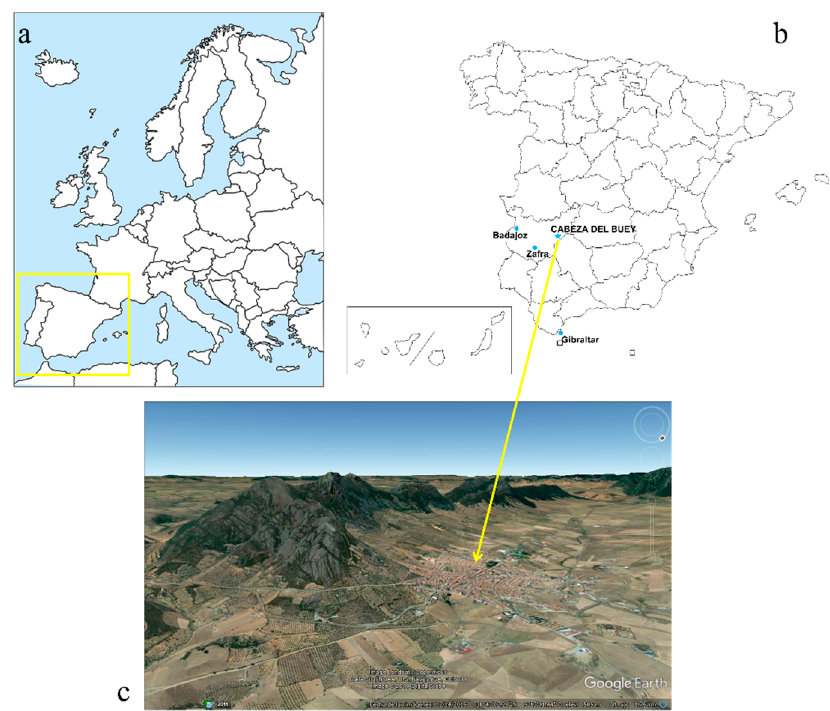
Figure 1. ( a ) Location of Spain; ( b ) location map of the study area (Cabeza del Buey) as well as other places where rainfall data were obtained (Badajoz, Zafra and Gibraltar); ( c ) topographic view of Cabeza del